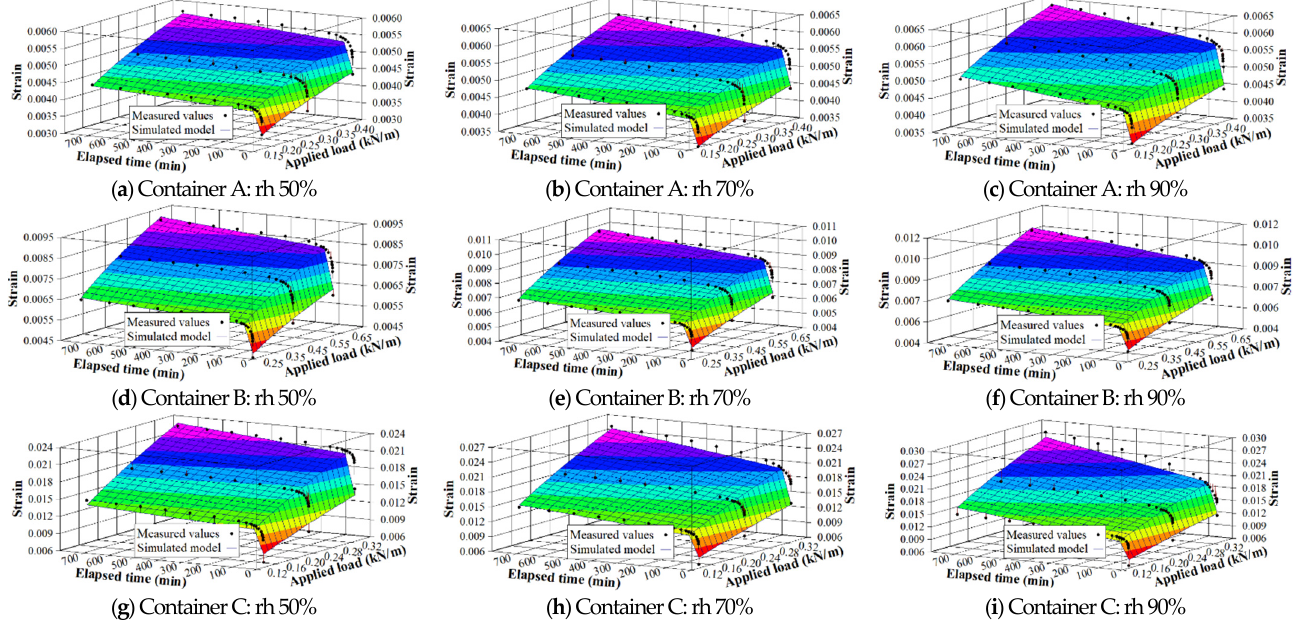
8 of 13 Table 5. SS behavior modeling results for the target shipping containers. Division